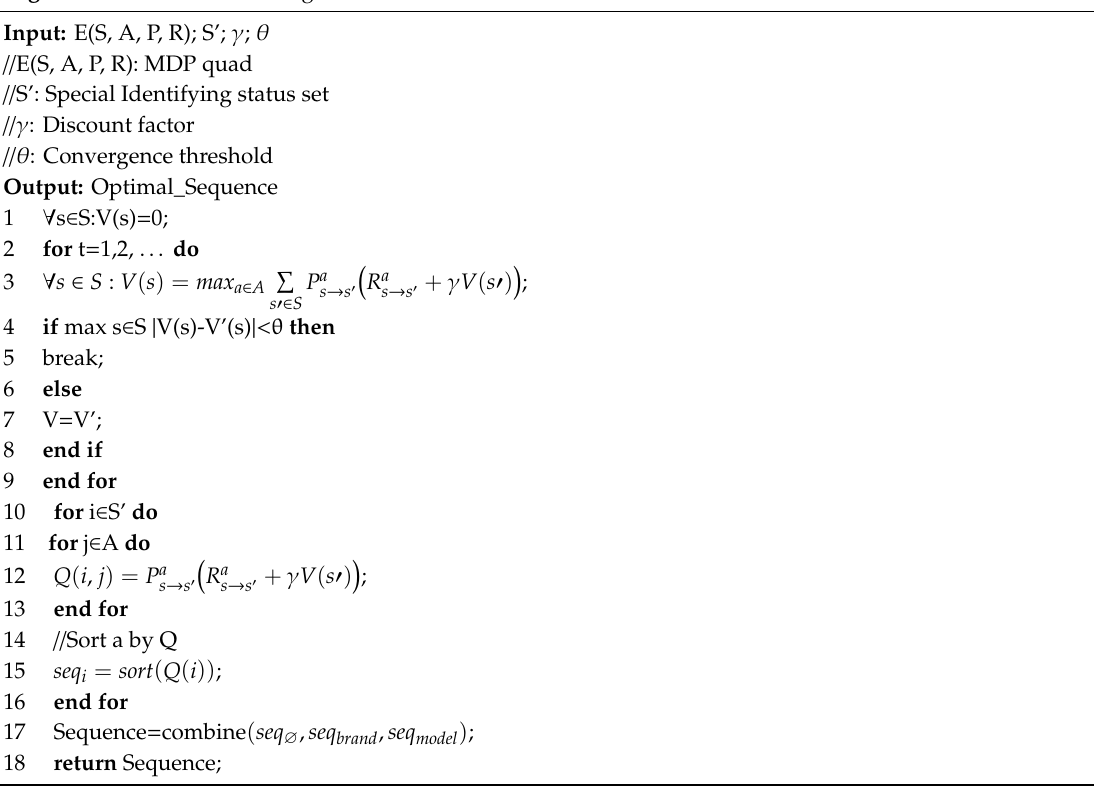
Algorithm 1 Value iteration